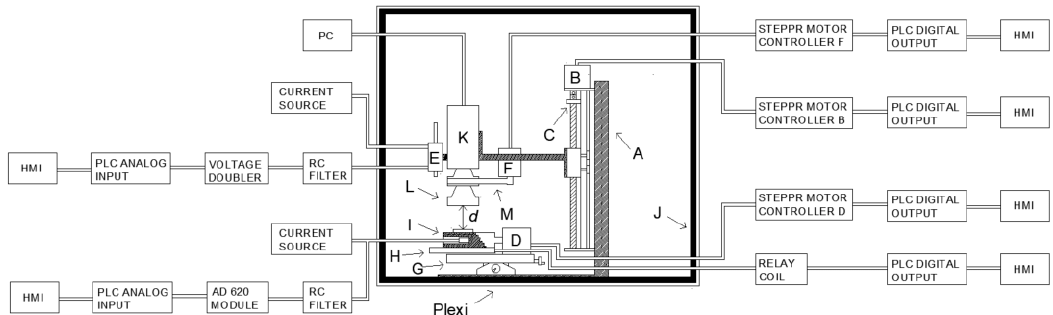
Figure 1. View of the schematic of measurement system: (A) Tripod; (B) Stepper motor; (C) Linear guide; (D) Stepper motor; (E) Resistance linear distance sensor; (F) Stepper motor; (G) Cross table; (H) Heating mat; (I) Aluminium bloc with Pt1000 temperature sensor; (J) Polyurethane foam; (K) Thermographic camera lens; (L) Additional macrolens; (M) Close-up lens 2 × P/NT 197,200 (d) WD (Work Distance)—distance between observed object and thermographic camera macrolens.